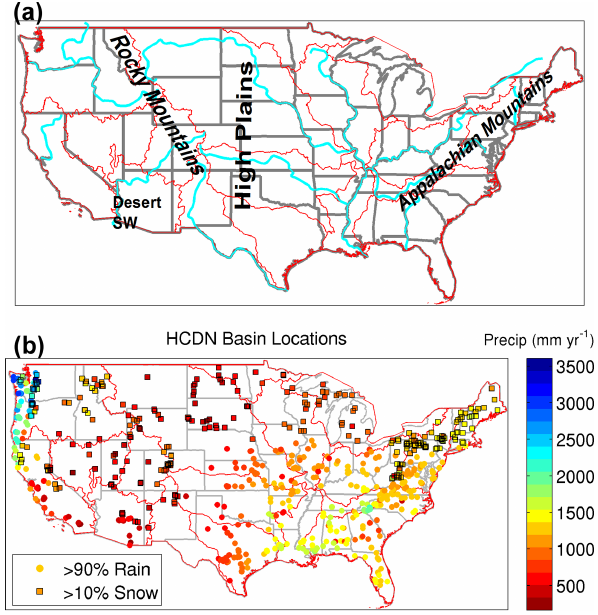
Figure 1. (a) Contiguous United States (CONUS) with states (gray), rivers (blue) and major hydrologic regions (red). Text in- dicates major geographic regions discussed in text. (b) Location of the 671 HCDN-2009 basins across the contiguous US used in the basin data set with precipitation shaded. Circles denote basins with > 90% of their precipitation falling as rain, squares with black outlines denote basins with > 10% of their precipitation falling as snow as determined by using a 0 ◦ C daily mean Daymet tempera- ture threshold. State outlines are in thin gray and hydrologic regions in thin